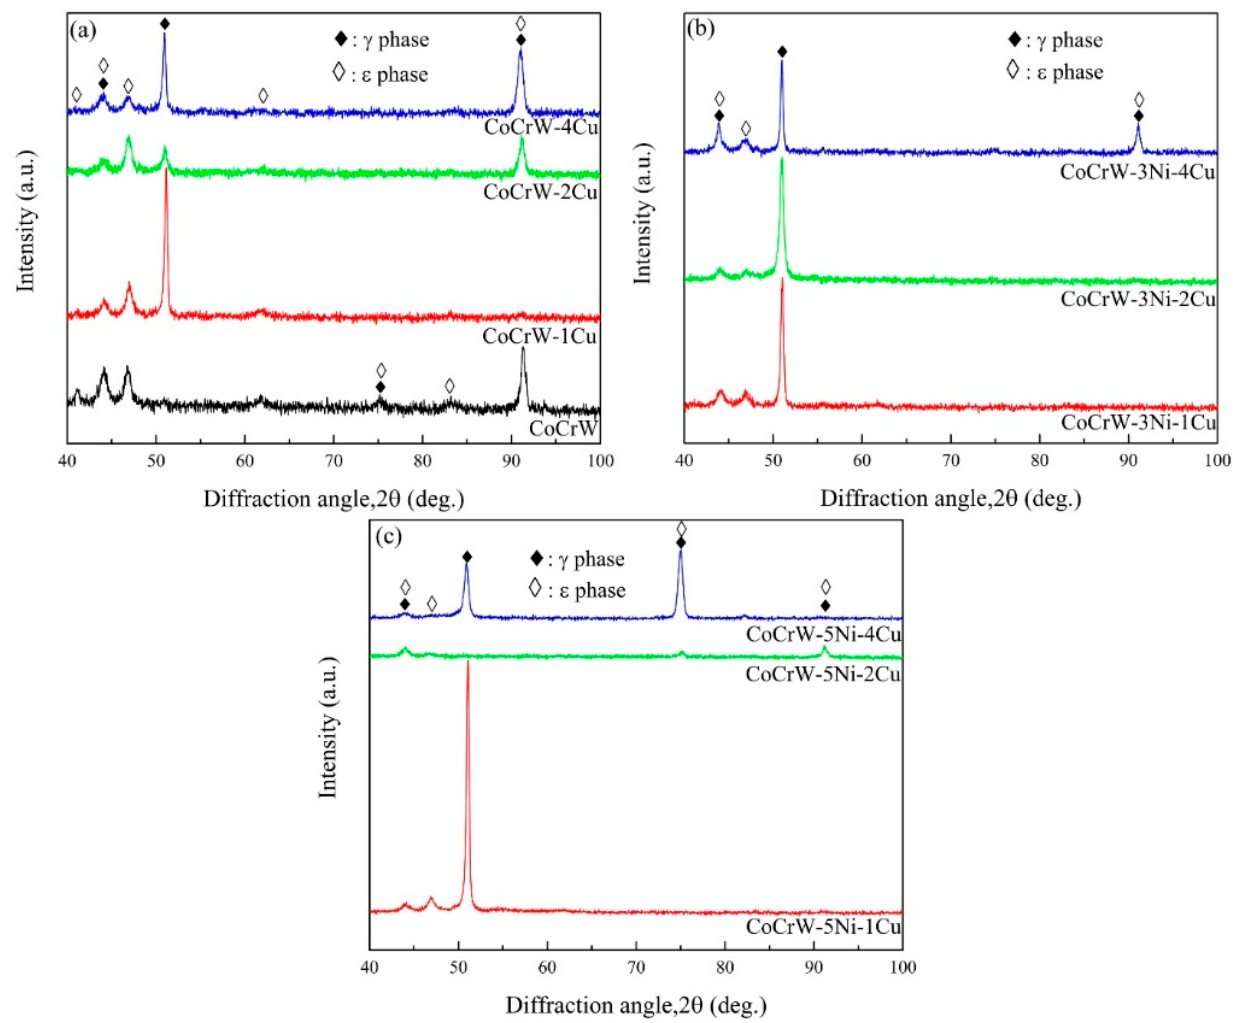
Figure 4. XRD patterns of the as-cast CoCrW-xNi-yCu alloys.